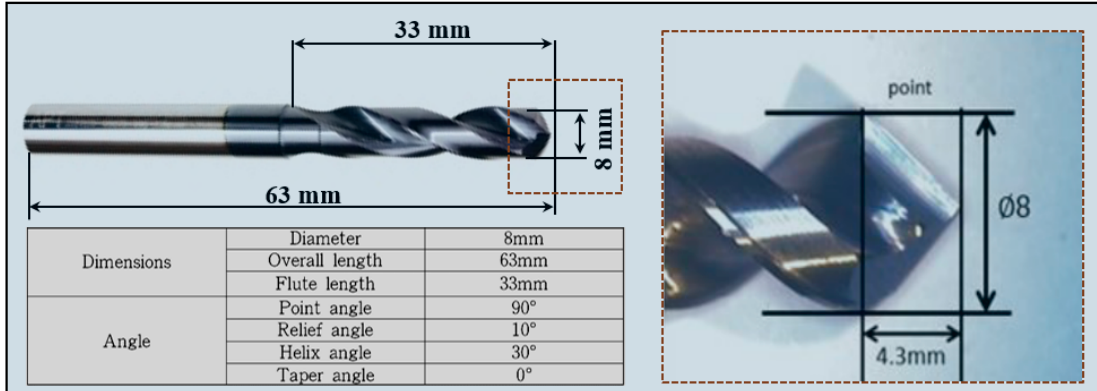
Figure 3. Cutting tool and drill specifications.